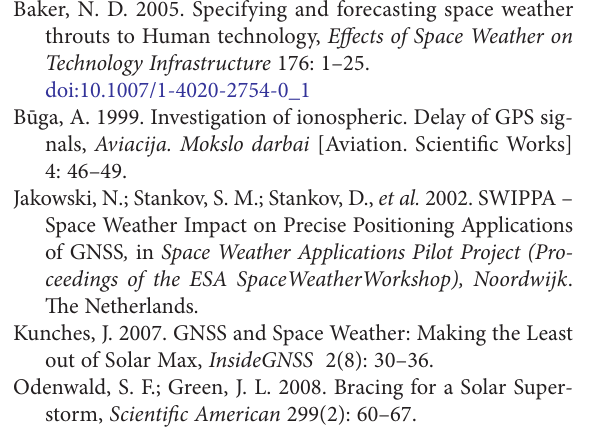
Fig. 4. Values of CPOS station called KRSS in 2010